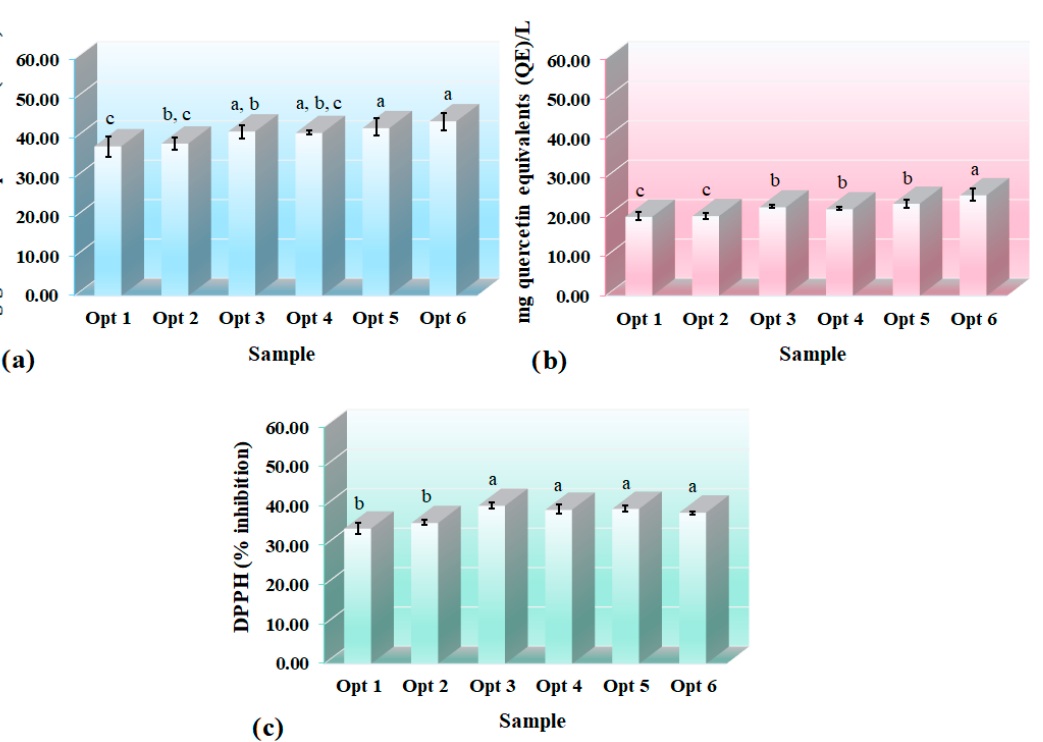
Figure 5. Bioactive compound content and in vitro antioxidant properties (( a ) phenolic content, ( b ) flavonoid content, and ( c ) the DPPH • scavenging activity) of the optimized formulations (Different letters indicate statistically significant differences ( p ≤ 0.05)) (in color) .